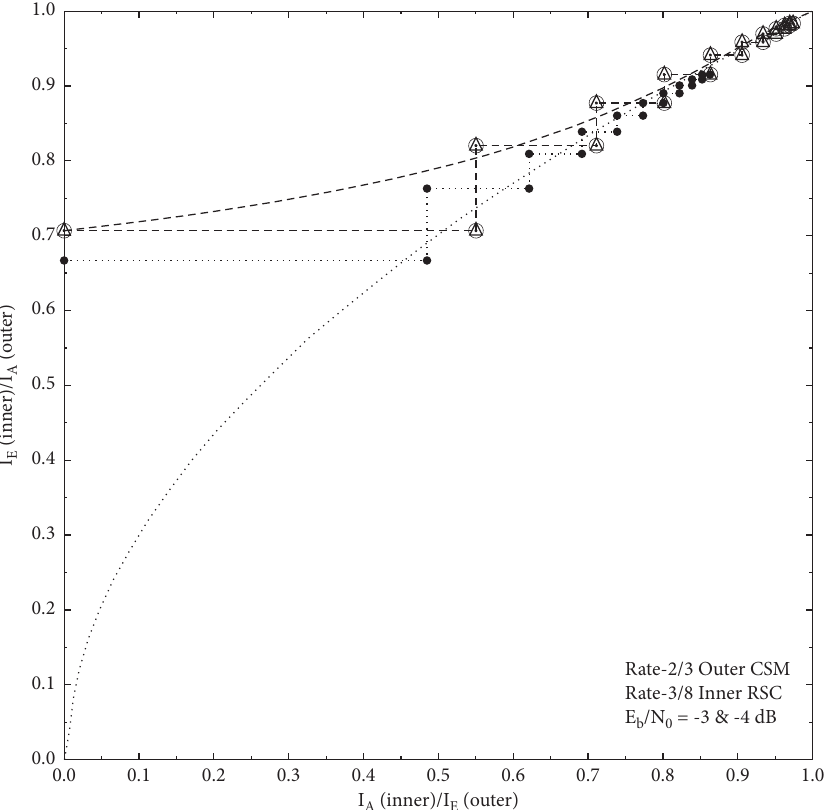
Figure 4: EXIT chart curves and decoding trajectories for Rate-2/3 CSM ( Mapping-I )